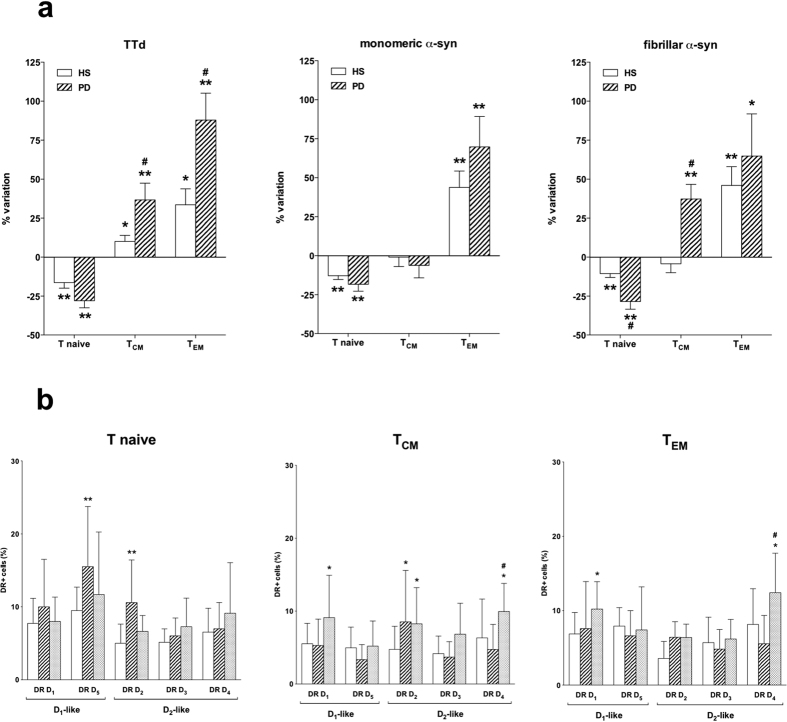
Effect of TTd, monomeric, and fibrillar α-syn on the frequency of CD4+ T naive and memory subsets.Panel (a) Effects of TTd (left), monomeric (middle), and fibrillar α-syn (right) in cells from HS (open columns) and PD patients (hatched columns). Data are expressed as percentage variation with respect to control conditions (without TTd or α-syn), and are means ± SEM of n = 6–8 separate experiments each performed in duplicate. * = P < 0.05 and ** = P < 0.01 vs. control conditions, and # = P < 0.01 vs. HS. Panel (b) monomeric (hatched columns), and fibrillar α-syn (shaded columns) on DR expression in T naive (left), TCM (center) and TEM cells (right) from 5 HS. Data are means ± SEM. * = P < 0.05 and ** = P < 0.01 vs control (open columns); # = P < 0.01 vs monomeric α-syn.